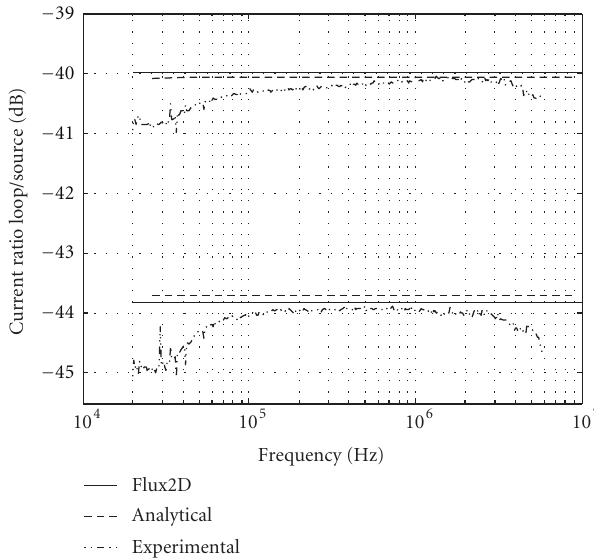
Figure 4: Dipole dB current ratio, sensor Q 10 1 (loop 2).